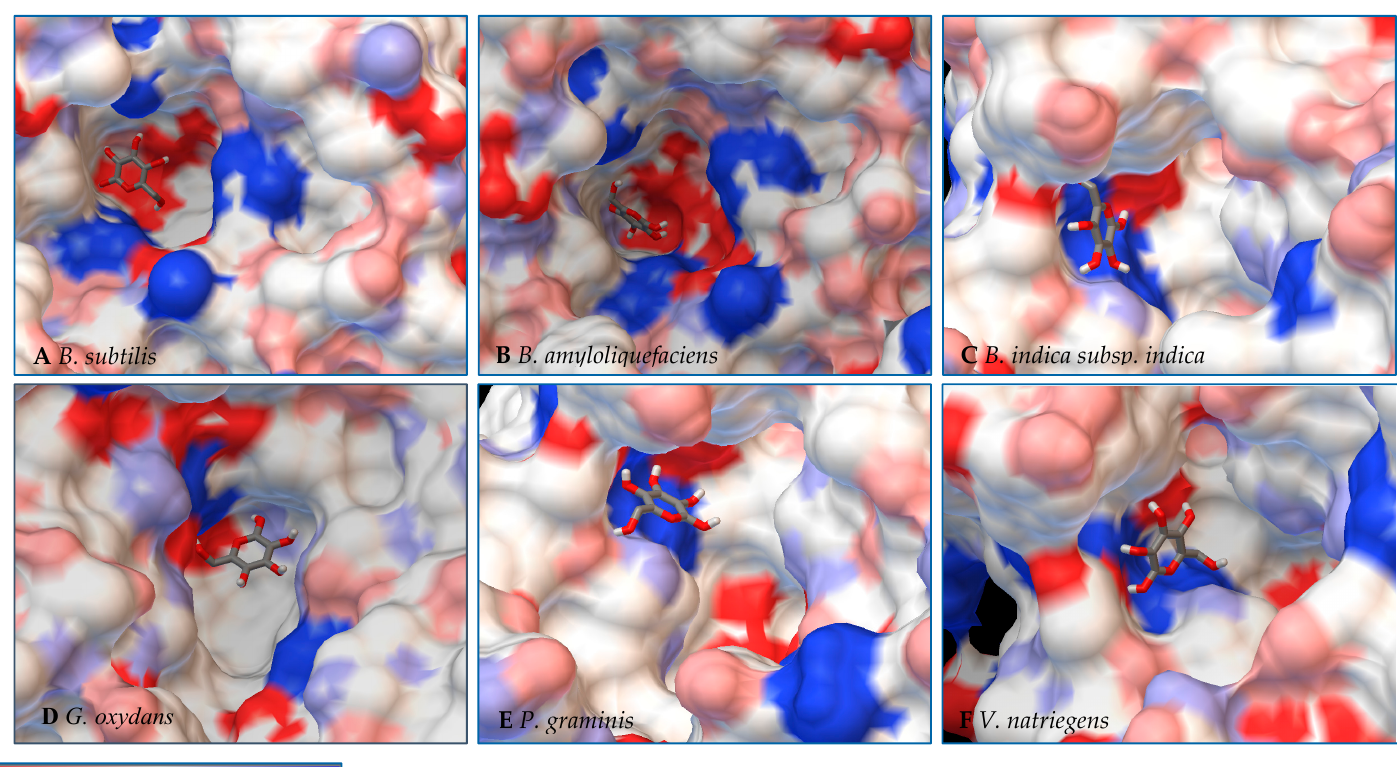
Figure 8. Models of LS from ( A ) B. subtilis, ( B ) B. amyloliquefaciens, ( C ) B. indica subsp. indica, ( D ) G. oxydans, ( E ) P. graminis , and ( F ) V. natriegens with glucose docked within the active site. Glucose is docked in a position representing the least binding energy state. Coloring represents the electrostatic surface potential (K b T / e c ) with a spectrum of red (electronegative) to blue (electropositive). The surface charge was calculated using AutoDock v 4.2 and the PDBqt file was uploaded to OPAL webserver for PQR map and visualization was done using PyMol APBS plugin.